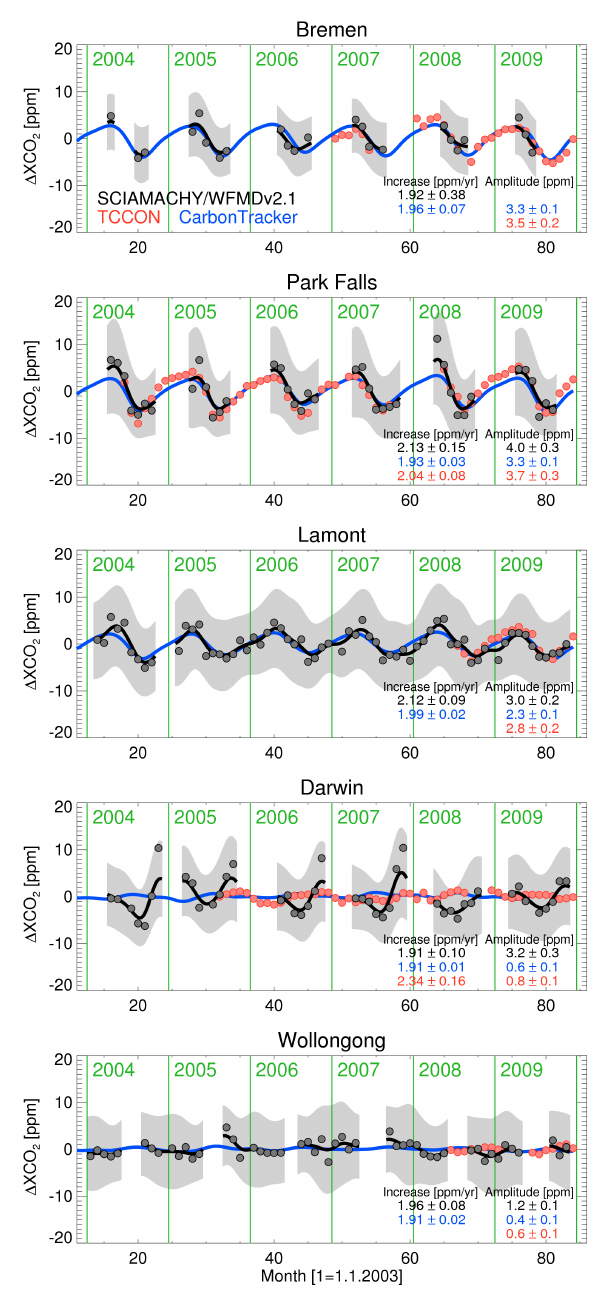
Fig. 2. Carbon dioxide time series with derived linear trends sub- tracted. The solid lines have been smoothed using a five-month Hann window (which has a similar frequency response to a two- and-a-half-month boxcar filter but better attenuation of high fre- quencies). The shaded areas represent the standard deviation of the unsmoothed satellite data. The annual increases and the am- plitudes of the seasonal cycle are stated for data sets with sufficient data available for computation (e.g., at least three years of data are required to reliably determine the annual increase). The complete results are summarised in Table